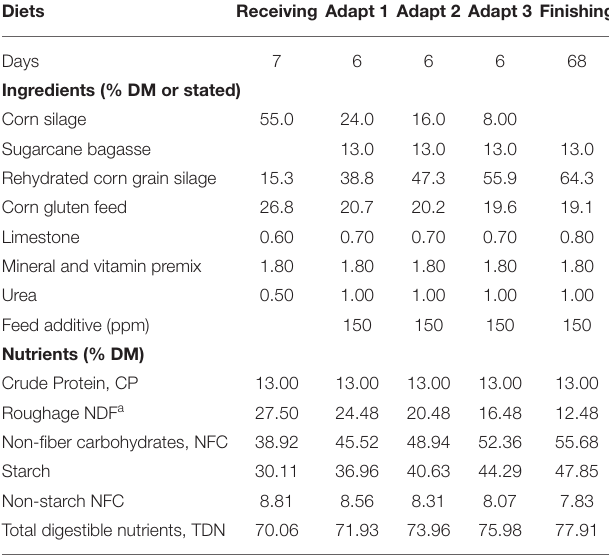
TABLE 1 | Composition of experimental diets according to feeding phase of crossbred finishing bulls, over a trial period of in total 94 days (dry matter basis DM, unless otherwise